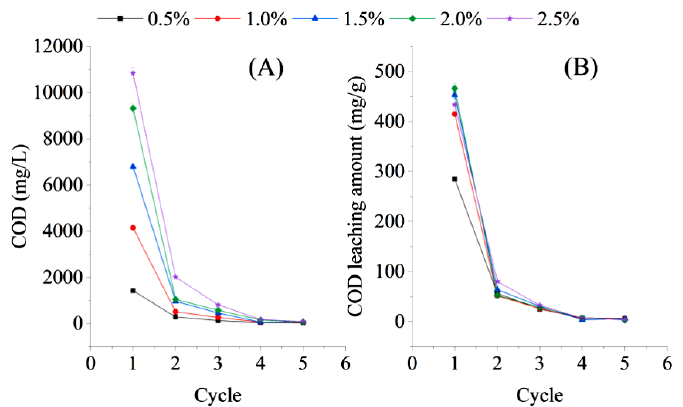
Figure 4. Chemical oxygen demand (COD) leaching concentration ( A ) and COD leaching amount ( B ) of bagasse under batch water replacement conditions during an experiment on the feasibility of using sugarcane bagasse as a carbon source in aerobic denitrification.